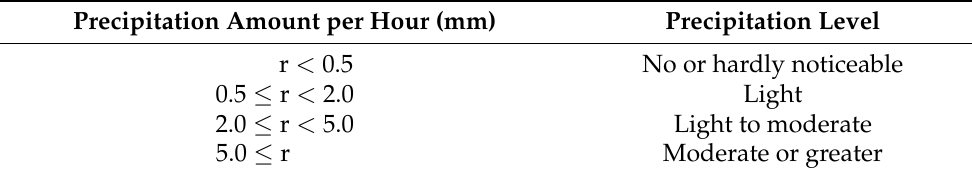
Table 3. Correspondence between threshold and precipitation